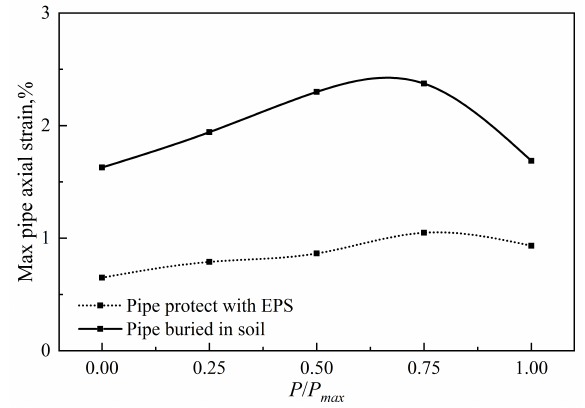
Fig. 7. Ovalisation parameter of pipe with different D / t .